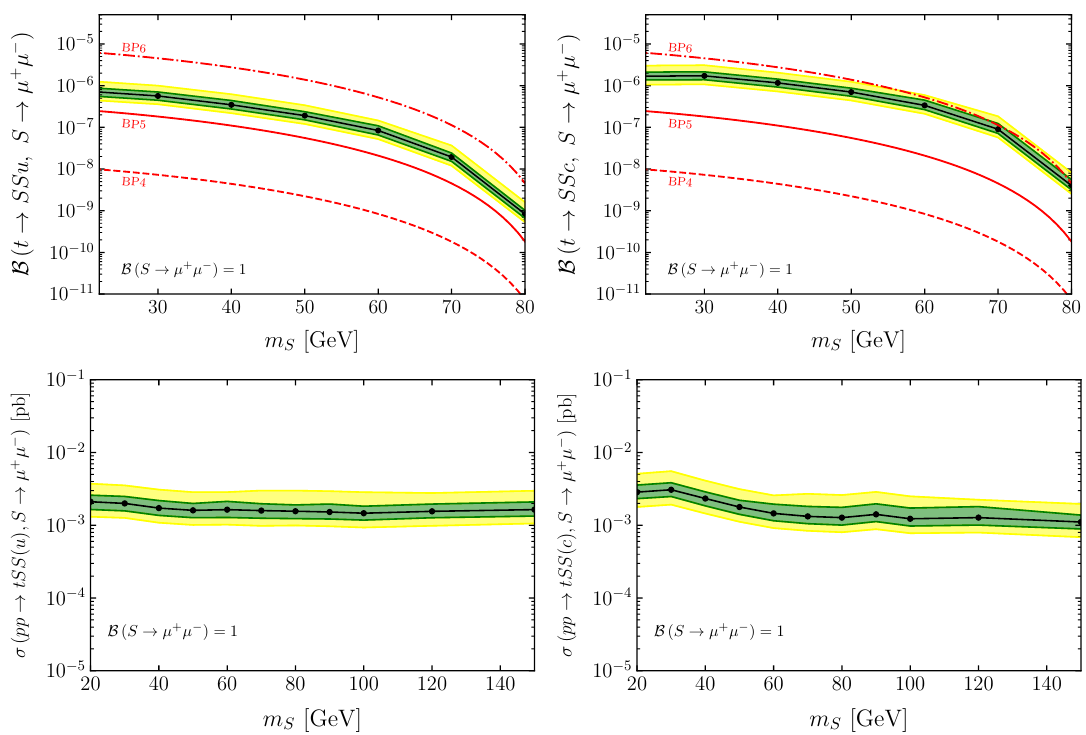
Figure 9 . In the upper (bottom) panels, we show the 95% CL limits on the branching ratio (cross section times branching ratio) that can be tested in the (cid:22) + (cid:22) (cid:0) channel, in the analysis proposed for t ! SSq; S ! (cid:22) + (cid:22) (cid:0) , with q = u ( c ) in the panels on the left (right). The green and yellow bands show the (cid:6) 1 (cid:27) and (cid:6) 2 (cid:27) uncertainty on the limits, respectively. The limits are obtained for a collected luminosity L = 150 fb (cid:0) 1 . Superimposed are the theoretical expectations in three